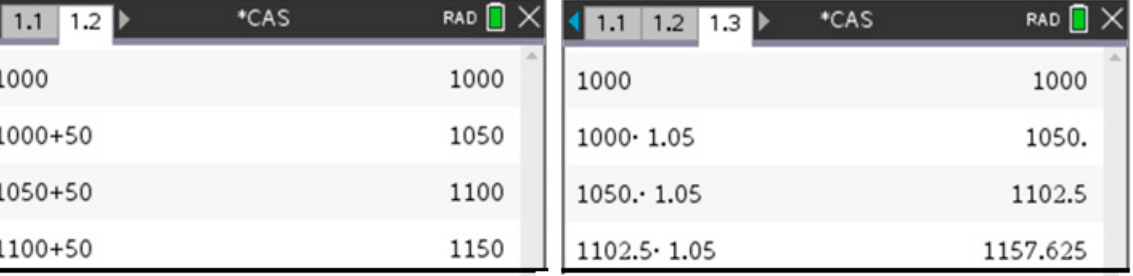
Figure 7. CAS screens for recursion showing the difference between simple and compound interest on an investment of $1000 with an interest rate of 5%.